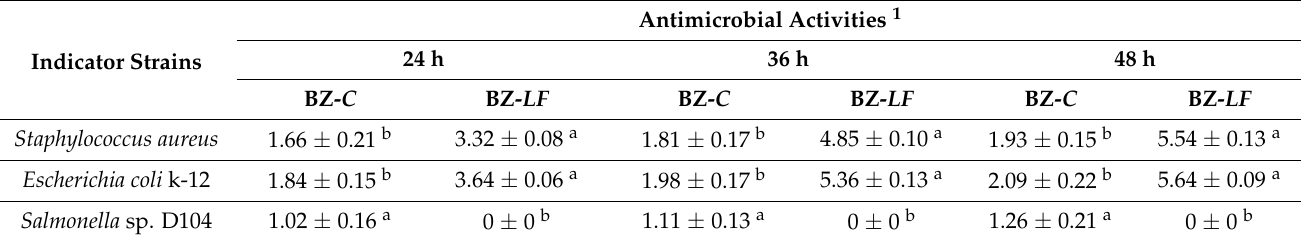
Table 1. In situ antimicrobial activities of prepared bozai treatments. Indicator Strains